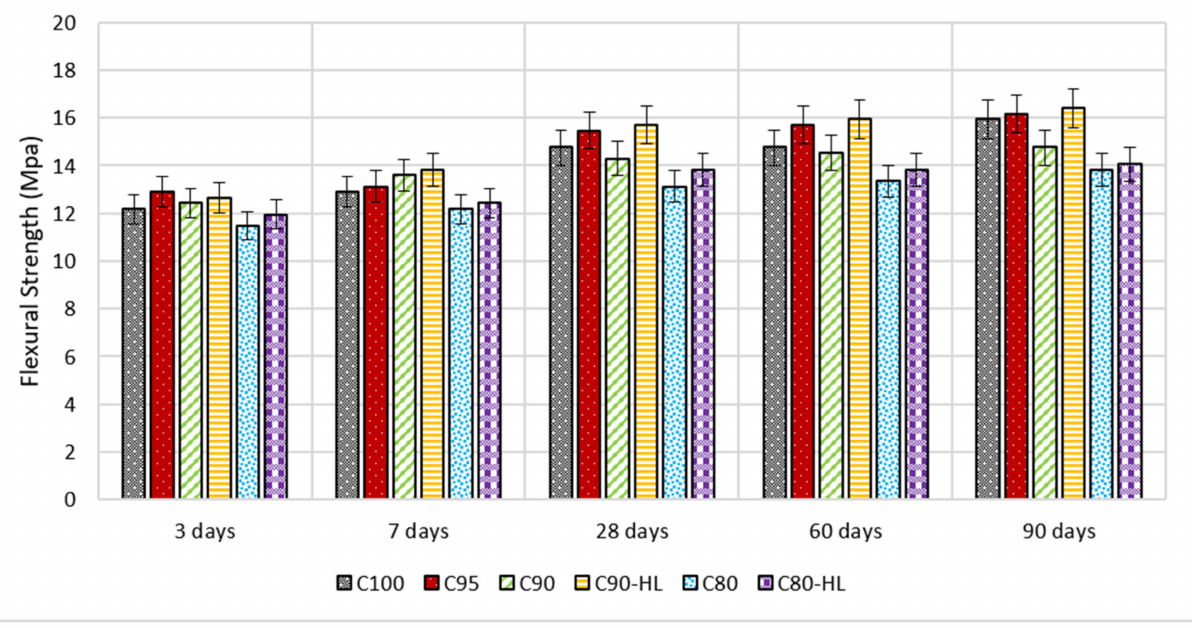
Figure 12. Self-compacting paste formulations’ flexural strength at various replacement